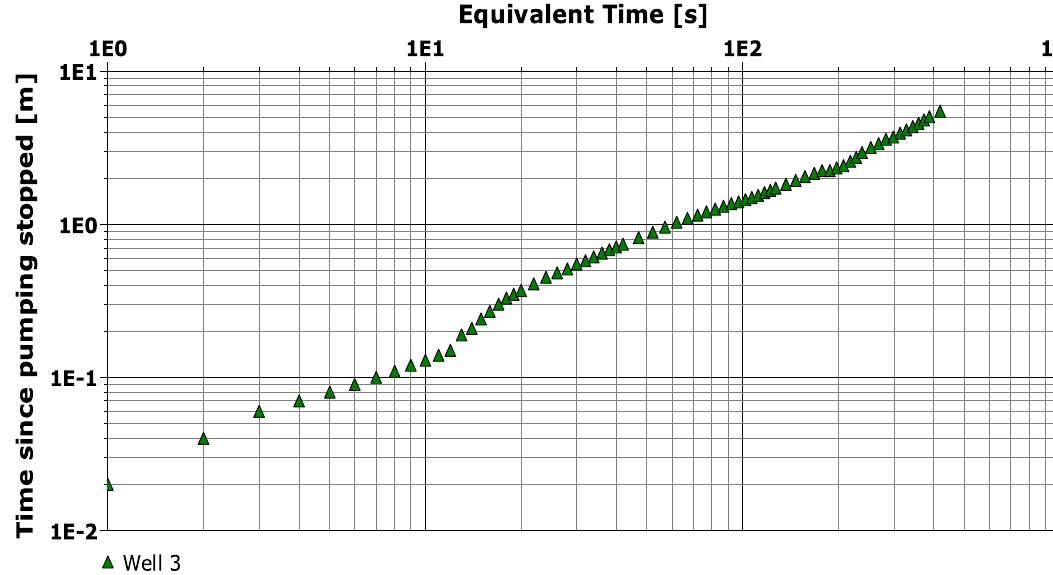
Fig. 8 Plotting of recovery rate of well-3 using aquifer mapping